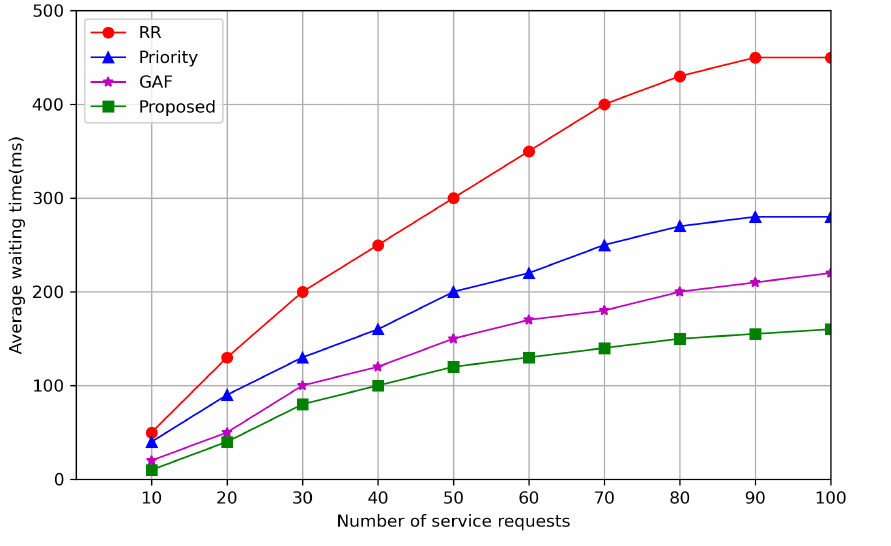
Figure 12. Performance evaluation by using average waiting time with the number of service